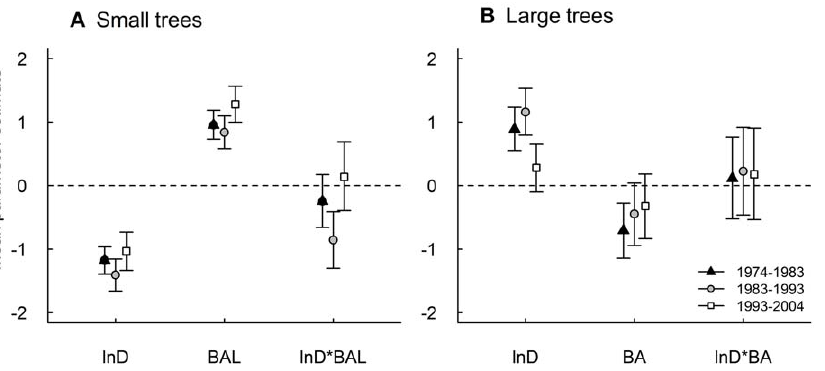
Figure 4. Mean parameter estimates for full individual-based mortality models. Parameter estimates are shown for ( A ) small (D , 20 cm) and ( B ) large (D $ 20 cm) trees. Each group of three points, for each parameter, represents estimates for the 1974–1983 (black triangle), 1983–1993 (grey circle) and 1993–2004 (white square) census periods. Bars show the 95% credible interval for the parameter estimates. D=diameter (mm), BAL=basal area of larger neighbours (m 2 plot 2 1 ), BA=basal area of all neighbours (m 2 plot 2 1 ).